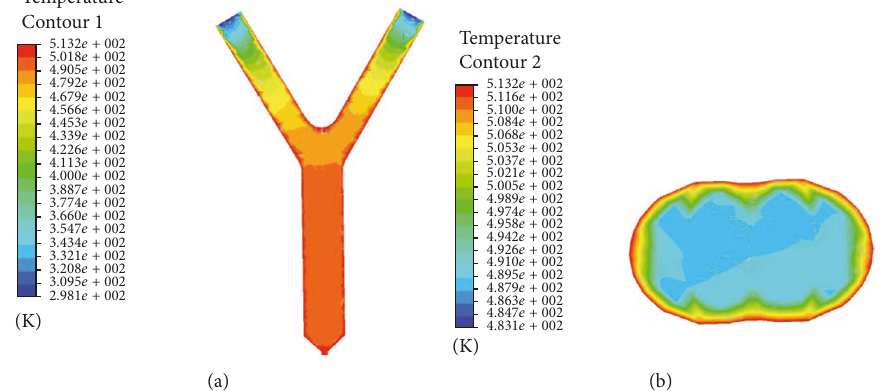
Figure 11: Temperature contours in the steady state at the temperature of 513.15 K at the time of 10s: (a) temperature contours of the flow channel; (b) temperature contours of the intersection cross